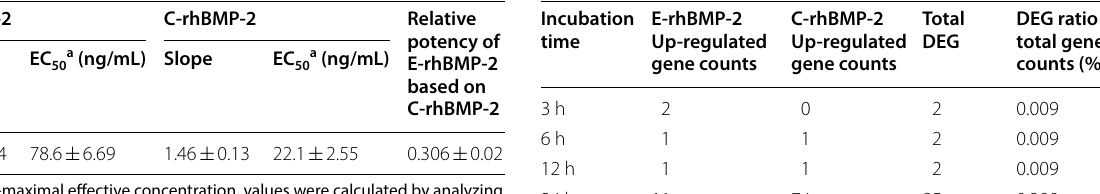
Table 2 Comparison of in vitro biological activity between Table 3 Differentially expressed genes between E‑rhBMP‑2